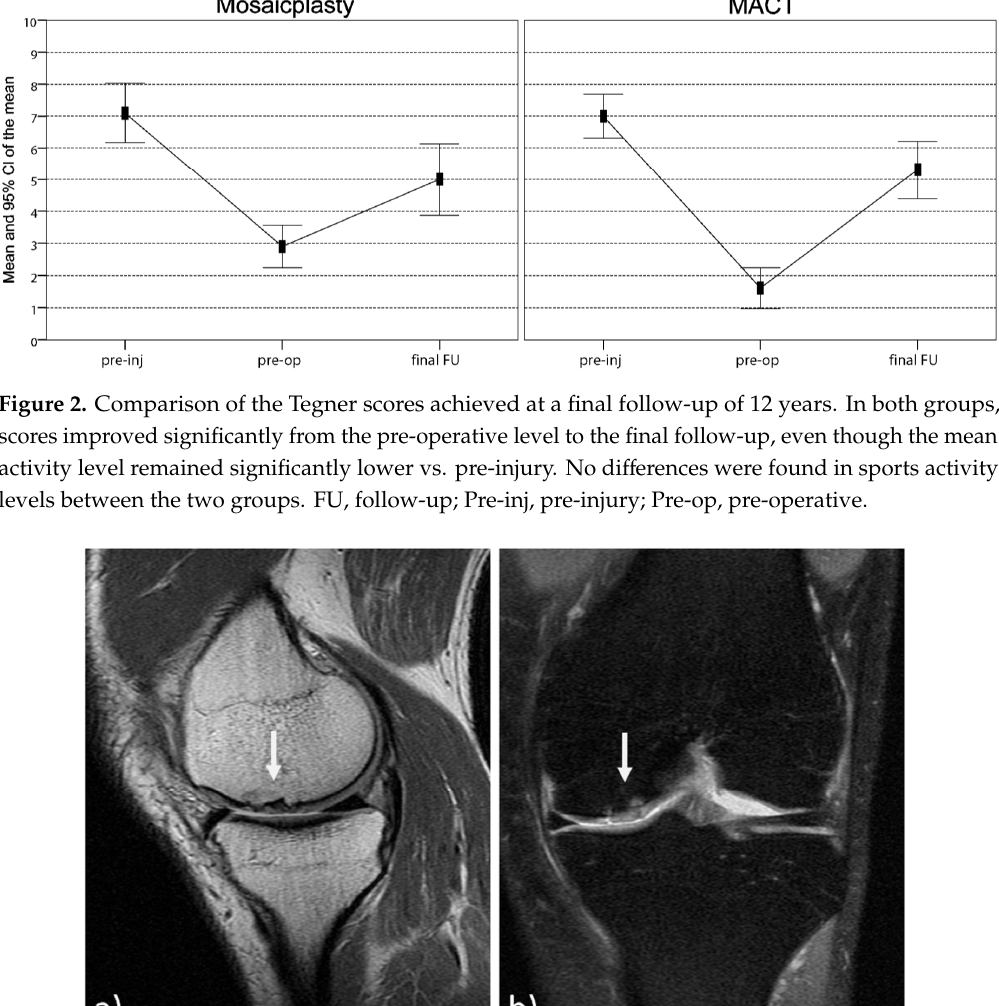
Figure 2. Comparison of the Tegner scores achieved at a final follow-up of 12 years. In both groups, scores improved significantly from the pre-operative level to the final follow-up, even though the mean activity level remained significantly lower vs. pre-injury. No differences were found in sports activity levels between the two groups. FU, follow-up; Pre-inj, pre-injury; Pre-op, pre-operative. Two patients of the mosaicplasty group failed (one with four plugs and one with three plugs) and were treated with MACT 2 years after the treatment, fixing a 10% reoperation rate. At the final mean follow-up of 12 years, three more patients in the mosaicplasty group (one patient with one plug, one with two plugs, and one with four plugs) were considered clinical failures, for an overall failure rate of 25%, significantly higher compared to the MACT group, where no surgical or clinical failures occurred (p = 0.016).